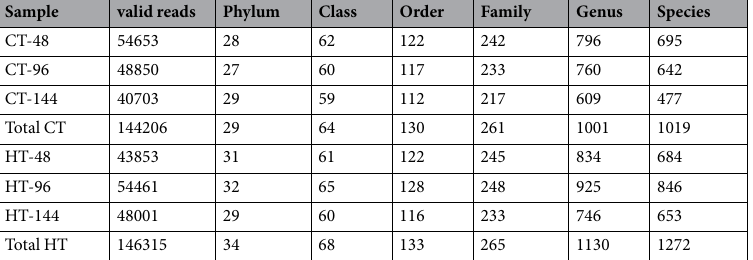
Table 2. Composition of microbial communities in the control and THTT silkworm samples. Collected samples were named with the convention CT/HT-N with CT representing control sample, HT representing high temperature treatment sample and N representing the sample was collected at N h post- high temperature treatment.